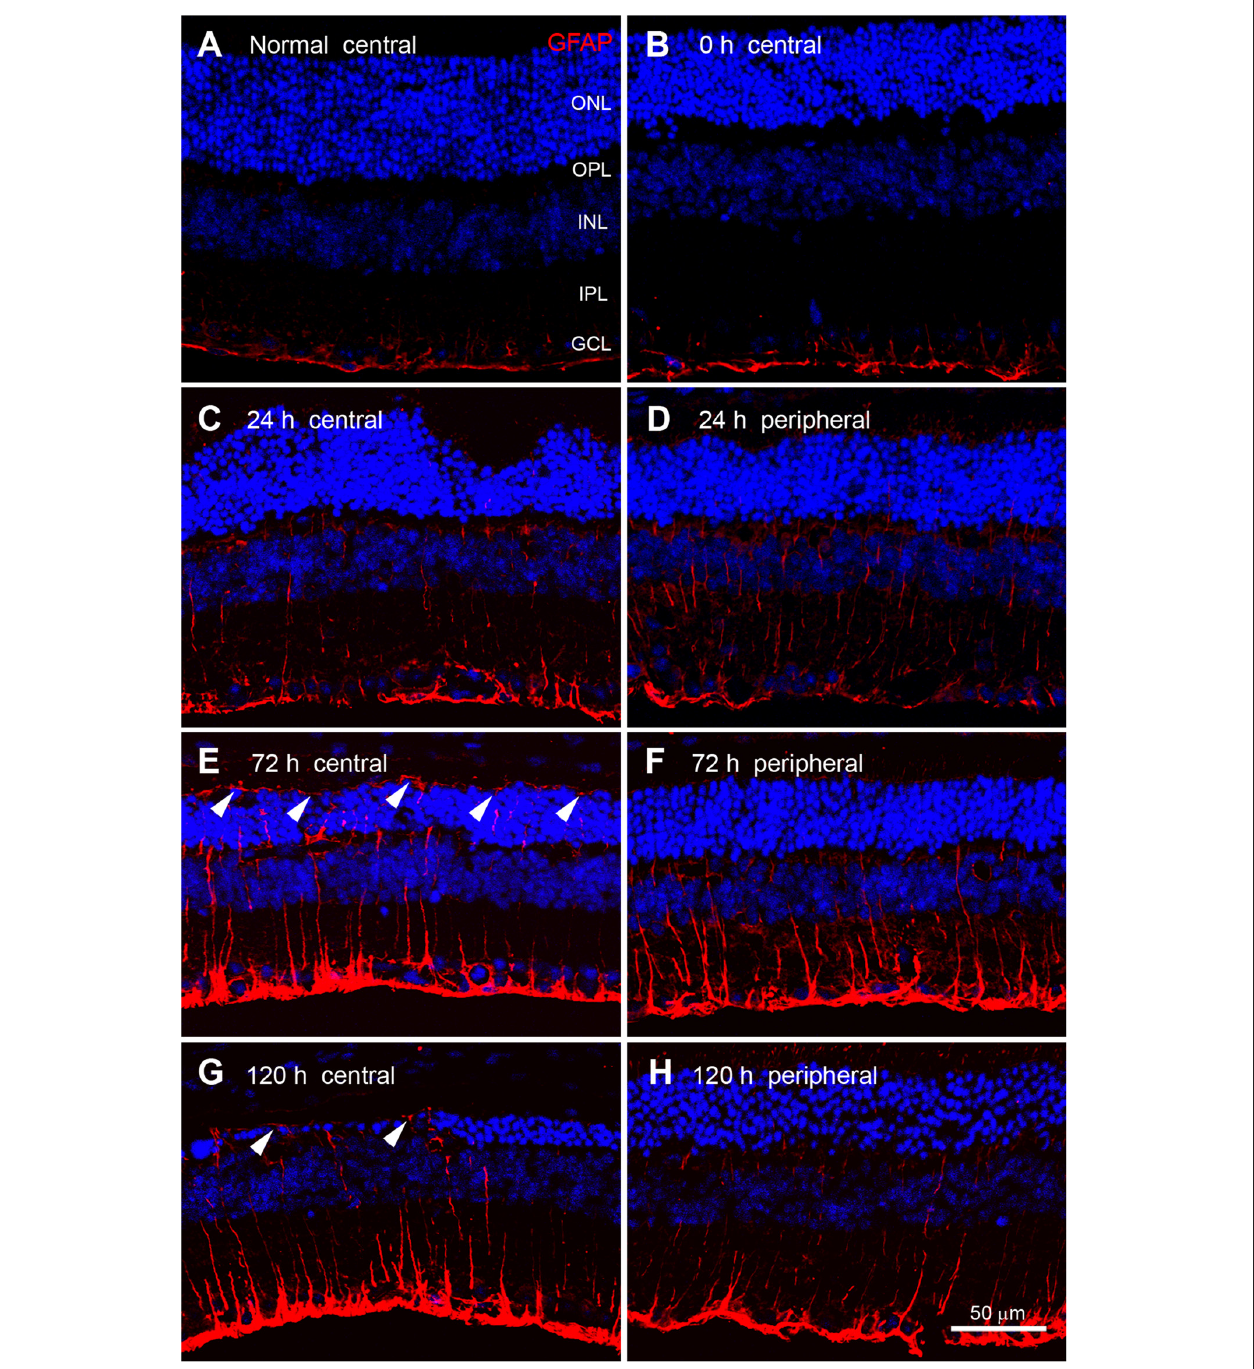
FIGURE 6 | Glial fibrillary acidic protein (GFAP) immunoreactivity in blue LED-induced RD retinas. Confocal micrographs taken from vertical sections of the central (left panel) and peripheral (right panel) retina processed for GFAP (red) immunoreactivity in normal (A) and blue LED-induced RD mice (B–E) . (A) A representative normal control retina. GFAP was expressed in astrocytes and Müller cell endfeet in the GCL. (B) A representative RD retina immediately after blue LED exposure (0 h). Expression of GFAP was similar to that in the normal control. (C,D) A representative RD retina at 24 h after blue LED exposure. GFAP immunoreactivity was slightly increased relative to 0 h. Thin GFAP-labeled Müller cell processes were found in the INL and the IPL. There were no differences in GFAP expression between the central (C) and peripheral (D) retina at this time point. (E,F) A representative RD retina at 72 h after blue LED exposure. GFAP immunoreactivity was increased in both the central (E) and peripheral (F) retina, particularly in the ONL of the central retina, where GFAP-labeled Müller cell processes (arrowheads) extended to the outer limiting membrane. (G,H) A representative RD retina at 120 h after blue LED exposure. GFAP immunoreactivity was decreased in both the central (G) and peripheral (H) retina, but GFAP-labeling (arrowheads) persisted in the outer limiting membrane.